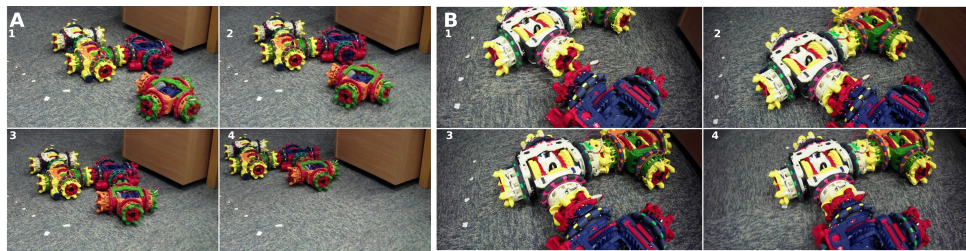
Figure 16. ( A ) The yellow robot (right) navigates to dock with port 3 of the white robot; meanwhile, a blue robot (left) in the “wandering” state avoids the forming structure. ( B ) The seed robot (blue) recruits for a robot to take a Temporary ID of 3 (the white robot); the robots were positioned and held so that a further robot (green) could dock to this recruit before the recruit docked with the seed. This image sequence shows the use of co-ordinated MNS motion to enable a docking between the two robot groups and the seed. See S6 in the Supplementary Material for video